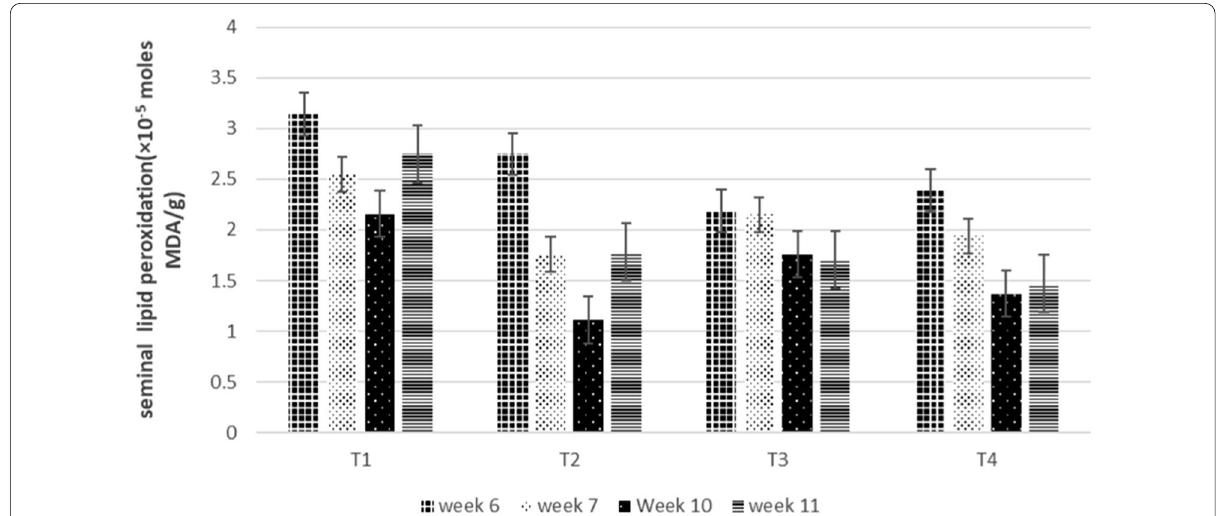
Fig. 5 Seminal lipid peroxidation in heat-stressed bucks administered ascorbic acid, sodium bicarbonate and its